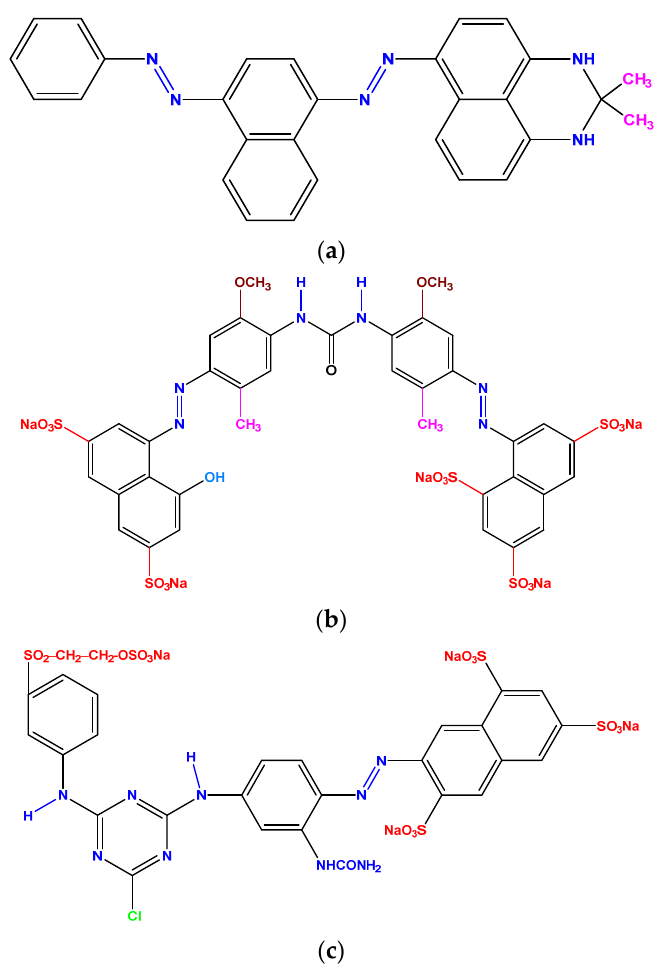
Figure 1. Chemical structure of different reactive dyes: ( a ) Sudan Black B, ( b ) Direct Red 6BL, and ( c ) Reactive Yellow 3RS with similar generic name as Deazol Black B EAN, Deafiz Red ME 6BL, and Firstfix Yellow 3RS, respectively.